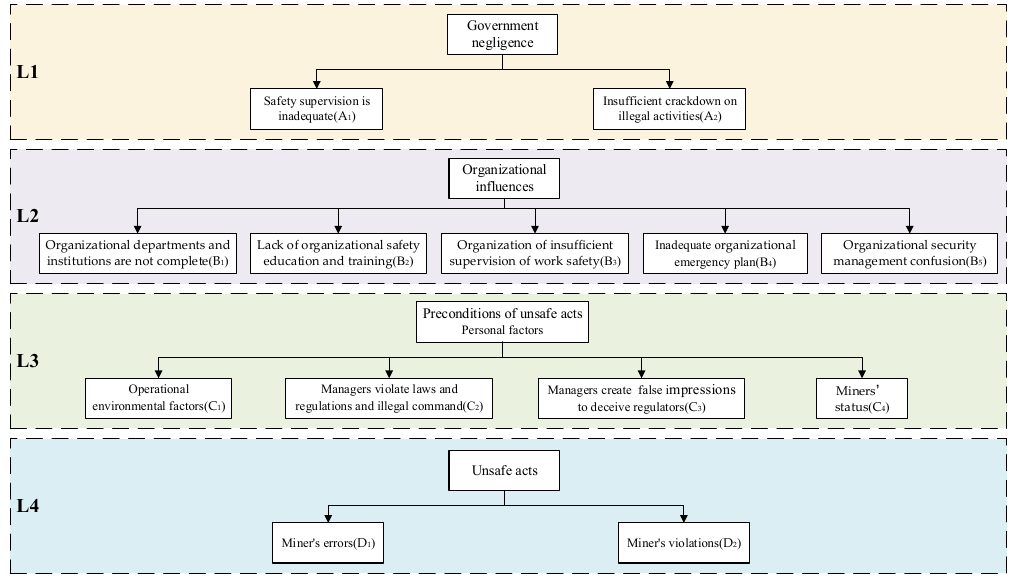
Figure 3. Improved HFACS framework. The identification of factors at each level in the improved HFACS framework is shown in Table